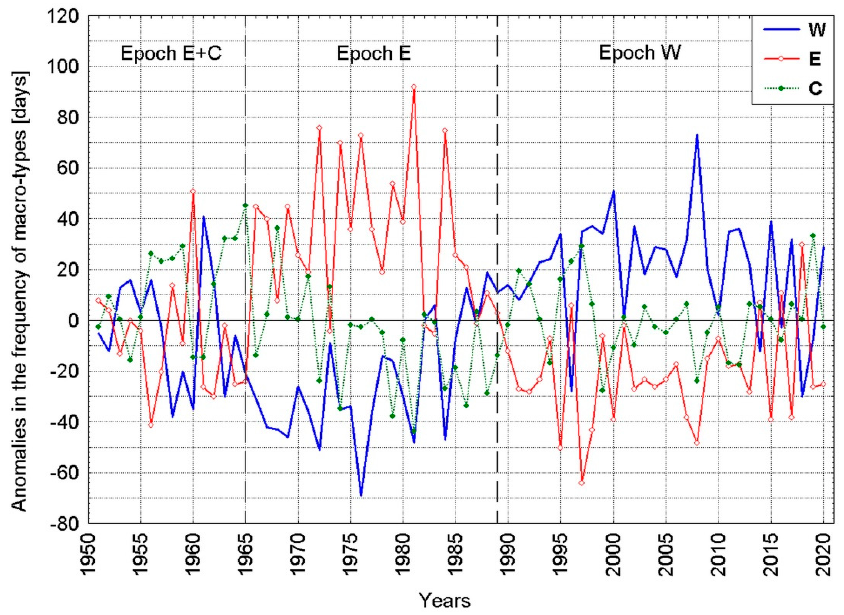
Figure 2. The course of the anomaly in the annual frequency of the mid-tropospheric circulation macro-types W, E, and C, according to the Wangengejm-Girs classification, in 1951–2020. Anomalies calculated based on averages from 1951–2000. Boundaries of the circulation epochs are marked with the vertical dashed lines. After 1988, the frequency of the meridional macro-type E fell sharply below its long-term mean value, while the frequency of the zonal macro-type W increased